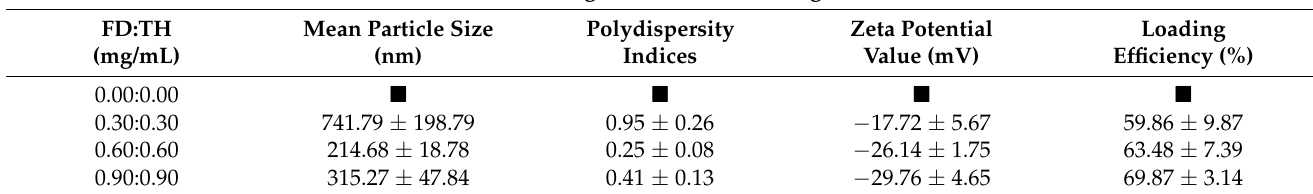
Table 1. Effect of different FD/TH proportions on particle sizes, polydispersity indices, zeta potential values, and drug loading efficiency of the prepared EGCG-loaded FD/TH/PG NPs ( n = 5). (cid:4) Precipitation of aggregates after centrifugation was observed.